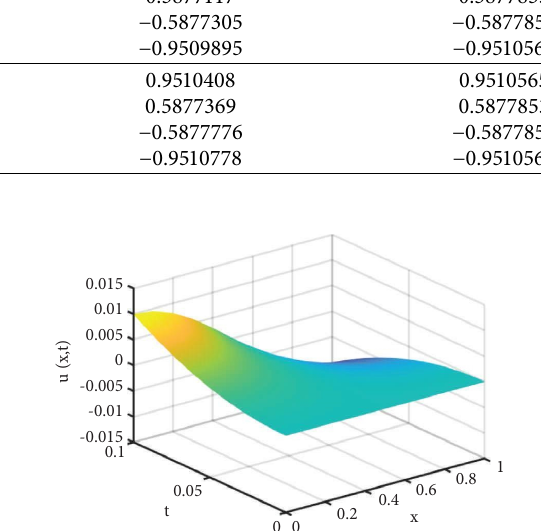
Figure 2: Numerical solutions of Example 1 at T � 0 . 1 with h � 0 . 0005, c � 0 . 72 ,v � 0 . 1, k � 10, and α � 0 . 5.